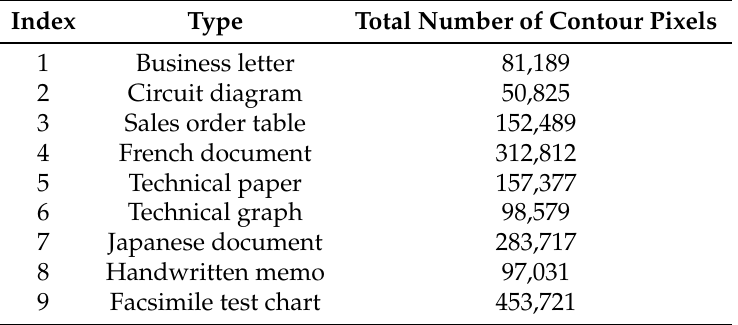
Table 6. CCITT (Consultative Committee for International Telephony and Telegraphy) fax standard